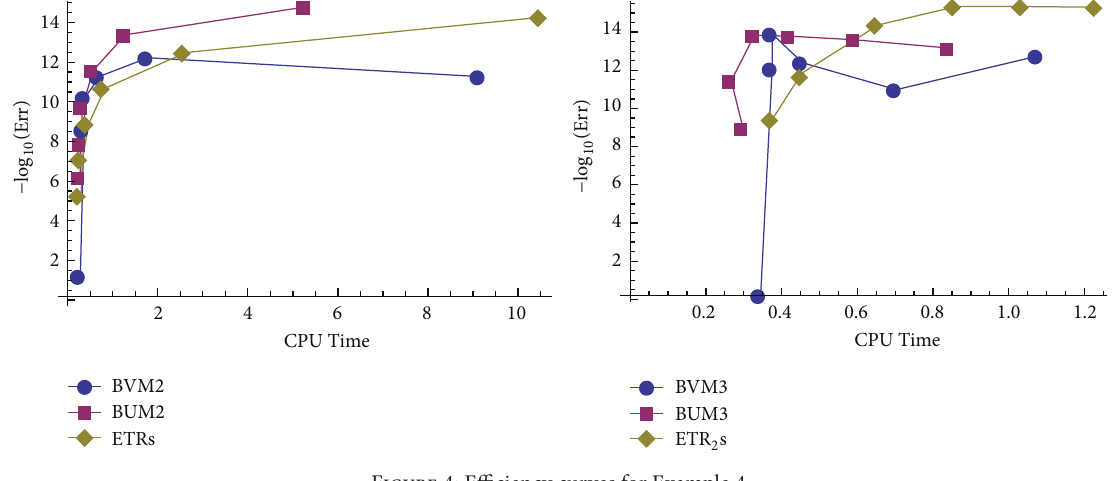
Figure 4: Efficiency curves for Example 4.